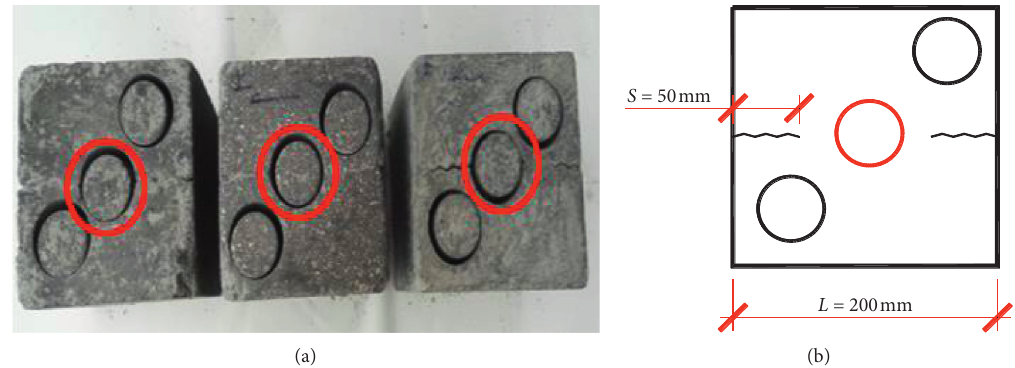
Figure 8: (a) Making specimens for the triaxial test. (b) Schematic diagram of sample drilling position.